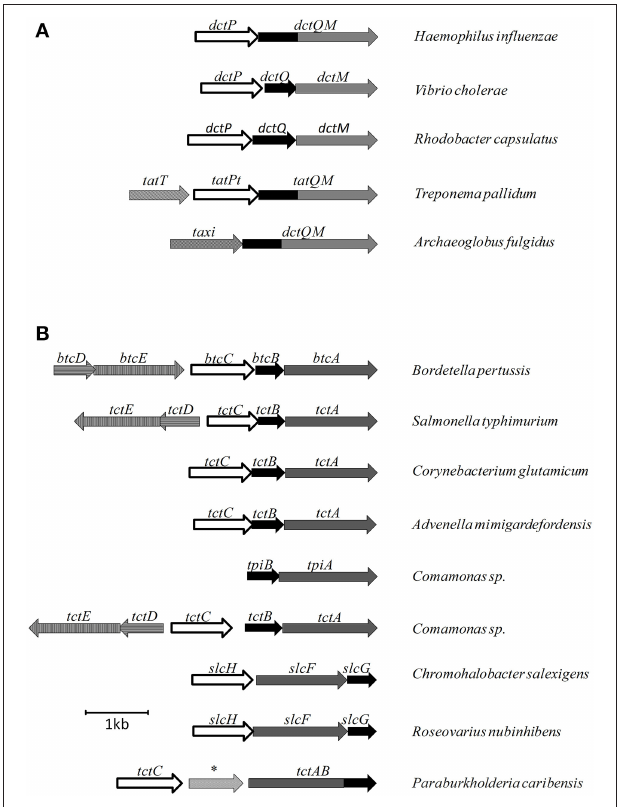
FIGURE 2 | Examples of genetic organization for different secondary SBP dependant transporters. (A) Gene organizations for TRAP systems. (B) Gene organization for TTT systems. * represents an amido-hydrolase